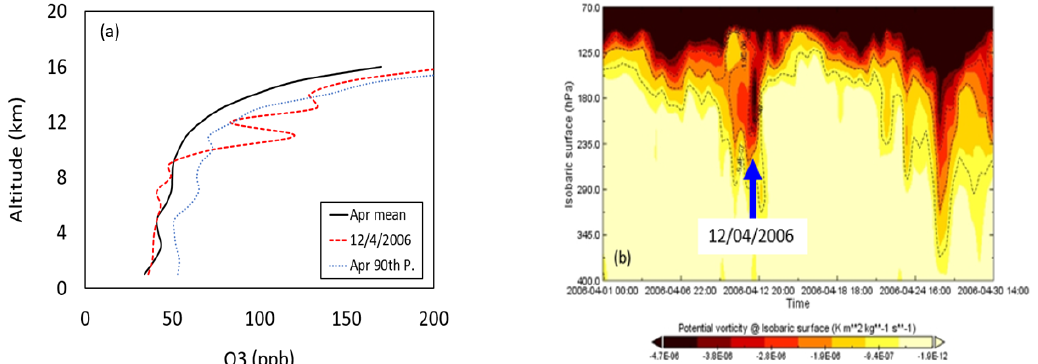
Figure 7. ( a ) Ozone troposphere profile over Irene on 12 April 2006. ( b ) Potential vorticity at Isobaric surface over Irene on July 2004 (from MERRA-2). Solid line in Figure 7a indicates monthly O 3 average composite, broken line indicates O 3 event and dotted line indicate 90 th percentile composite. Colours in Figure 7b indicates the level of potential vorticity, black indicates high potential vorticity of more than 3 Km −2 kg −1 s −1 while yellow indicates potential vorticity of less than 2 Km −2 kg −1 s −1 . Blue arrow in Figure 7b indicates the event that is associated with O 3 profile in Figure 7a.